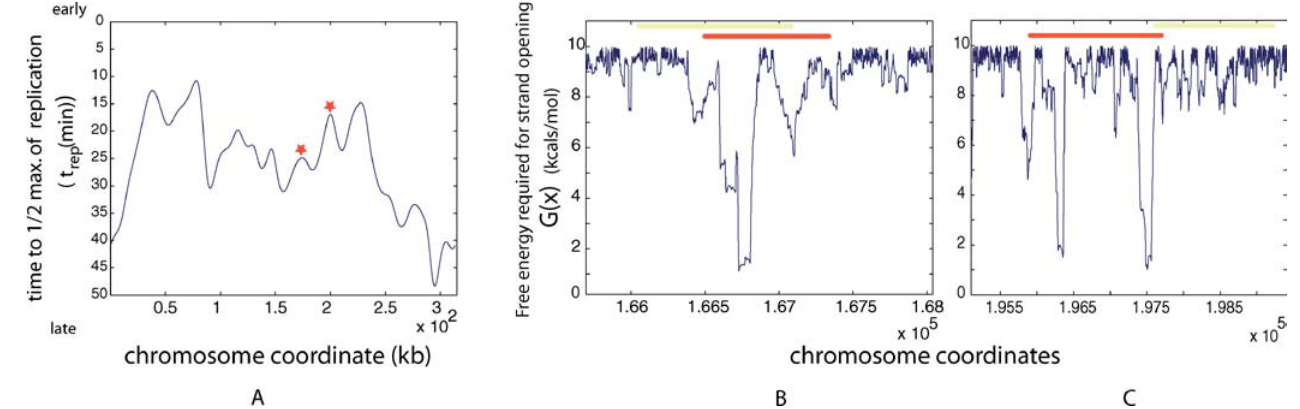
Figure 5. Localization of ARS Elements (A) Replication timing profile of Chromosome 3. The two peaks indicated by red stars are predicted with high confidence to contain replication origins. (Data replotted from [23].) (B and C) SIDD profiles of the two peak regions (from [A]) are plotted to high resolution, along with locations of the known ARS element (red) and the DNA segments within which ORC and MCM proteins were shown to bind [22] (yellow). (B) shows the profile around ARS 310, and (C) shows that of ARS 314. DOI: